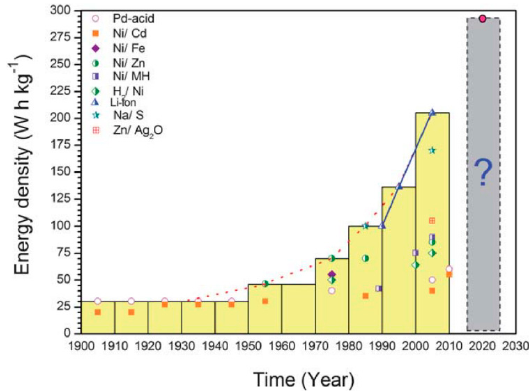
Figure 2. Increase in the energy density of the secondary batteries since 1900s. Adapted with permission from [7], © Royal Society of Chemistry, 2011.